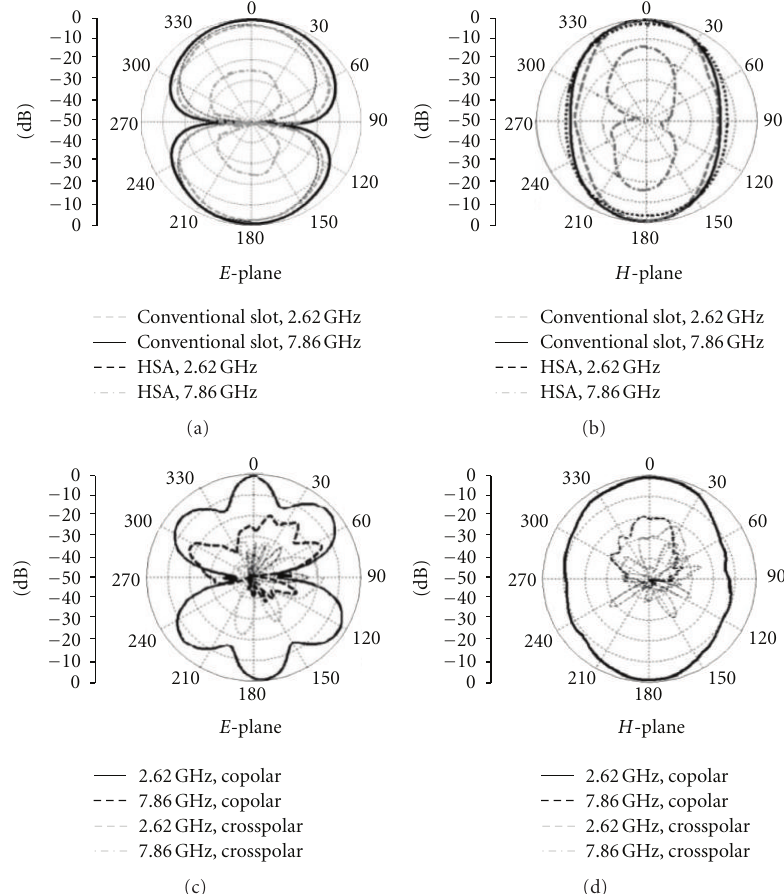
Figure 11: Simulated radiation patterns of both RDGS slot antenna and conventional slot antenna: (a) E-plane and (b) H-plane as well as measured patterns of only RDGS antenna: (c) E-plane and (d)